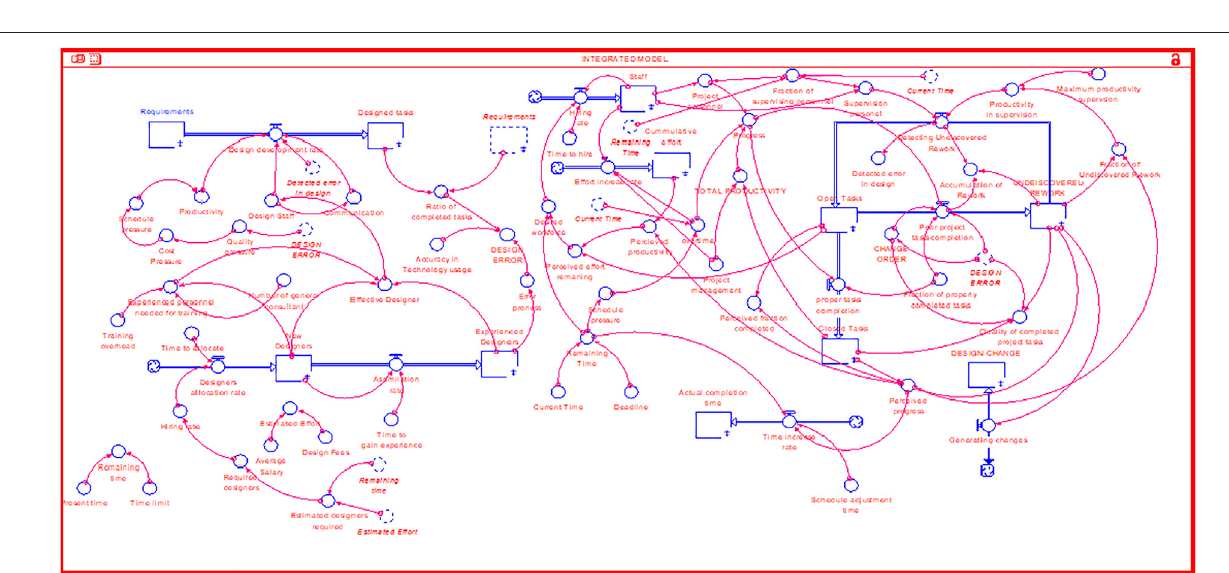
FIGURE 4 | The DEMATEL – SD model of construction